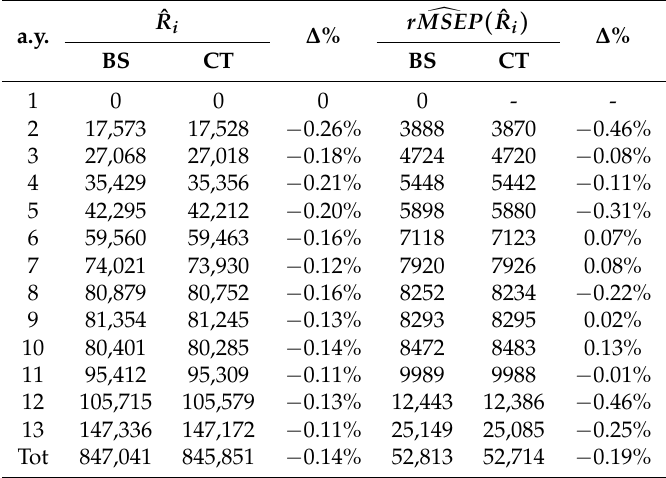
Table 7. Estimation of rMSEP ultimate: bootstrapping vs. closed